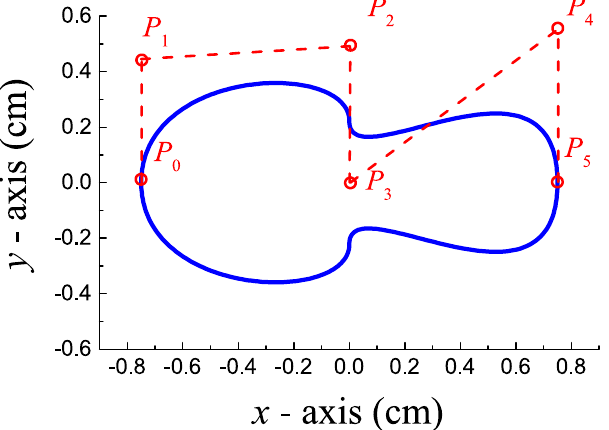
Figure 1. Representation of the cross-section of a typical Bézier cylindrical scatterer forming the cloak here designed. The blue line defines its external profile, which is obtained from the six control points P i ( i = 0 to 5). The coordinates of these points depend on five parameters that are obtained from the optimization process involving the scattering cancellation